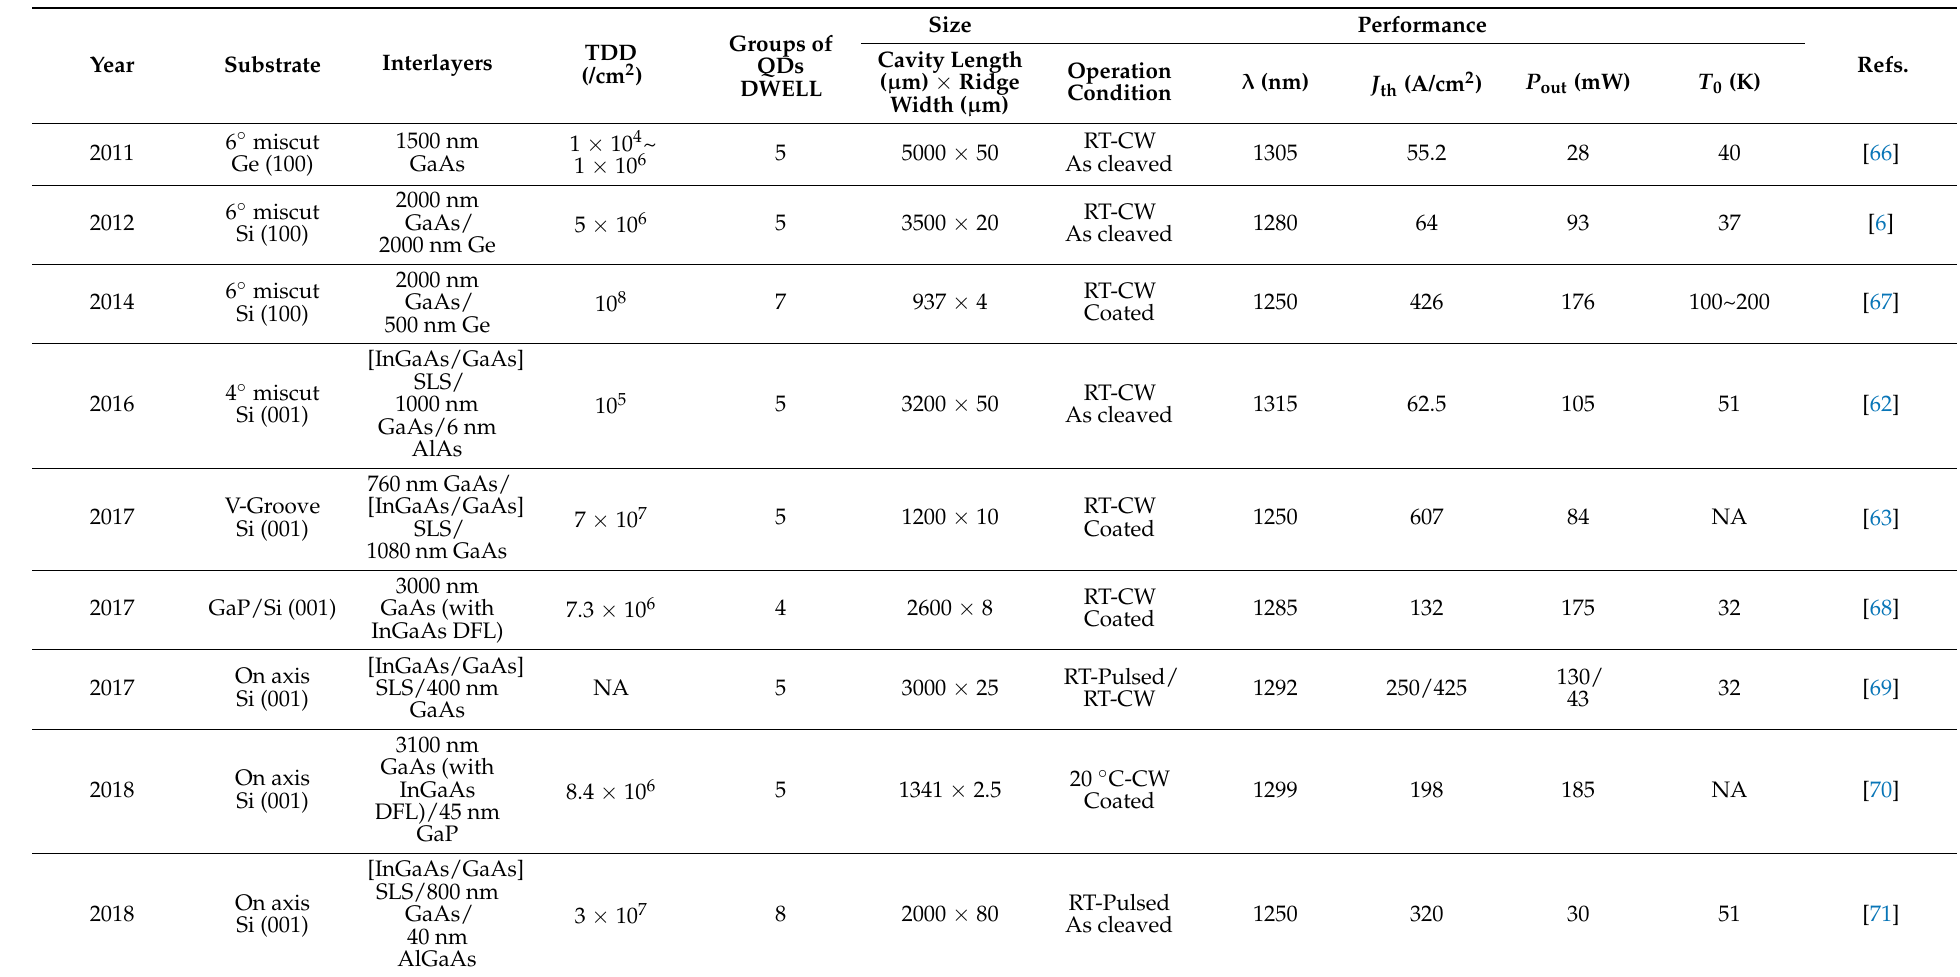
Table 1. Benchmarking of recent progress made in O-band InAs/GaAs QD lasers monolithically integrated on